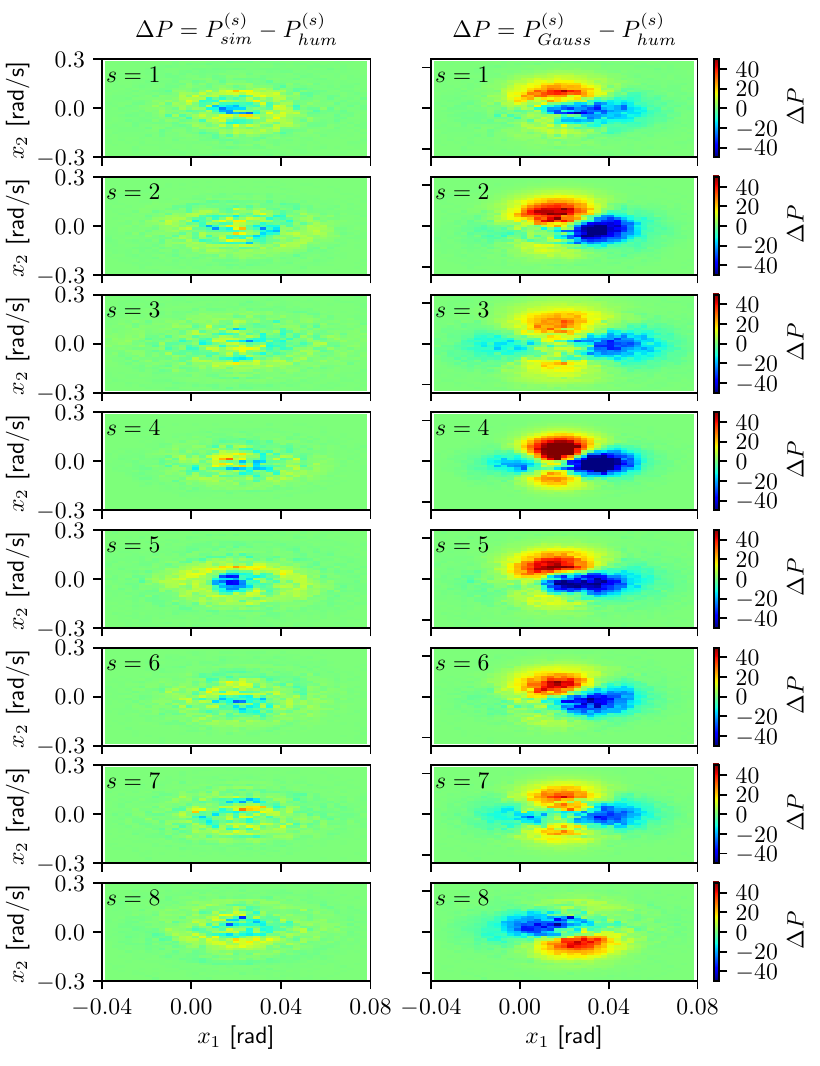
( x 1 , x 2 ) from the measured P ( s ) sim ( x 1 , x 2 ) (right column), for all s Gauss